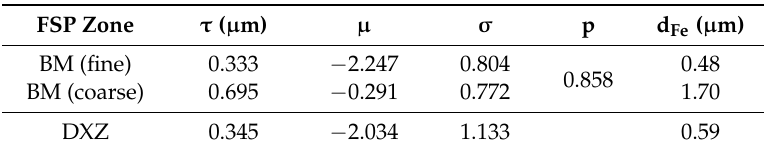
Table 1. Estimated parameters of the lognormal distributions and the fraction of each distribution in the